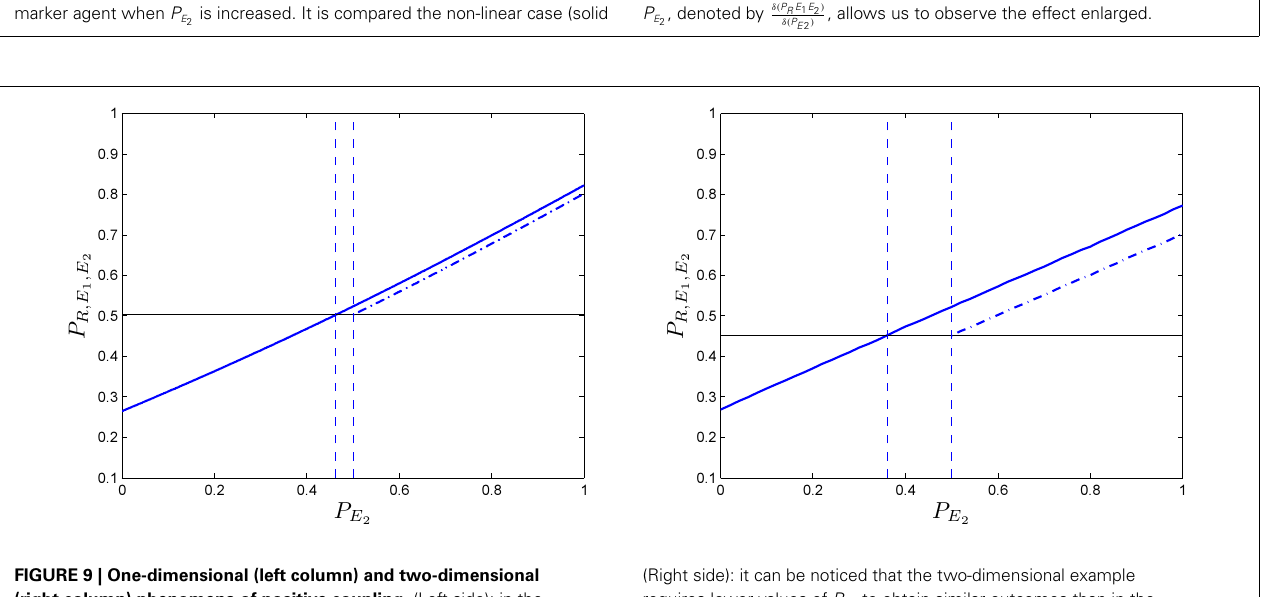
FIGURE 8 | Robustness of the phenomenon in which coupling is positive. (Left side): evolution of the predictive ability P X of the somatic marker agent when P E is increased. It is compared the non-linear case (solid 2